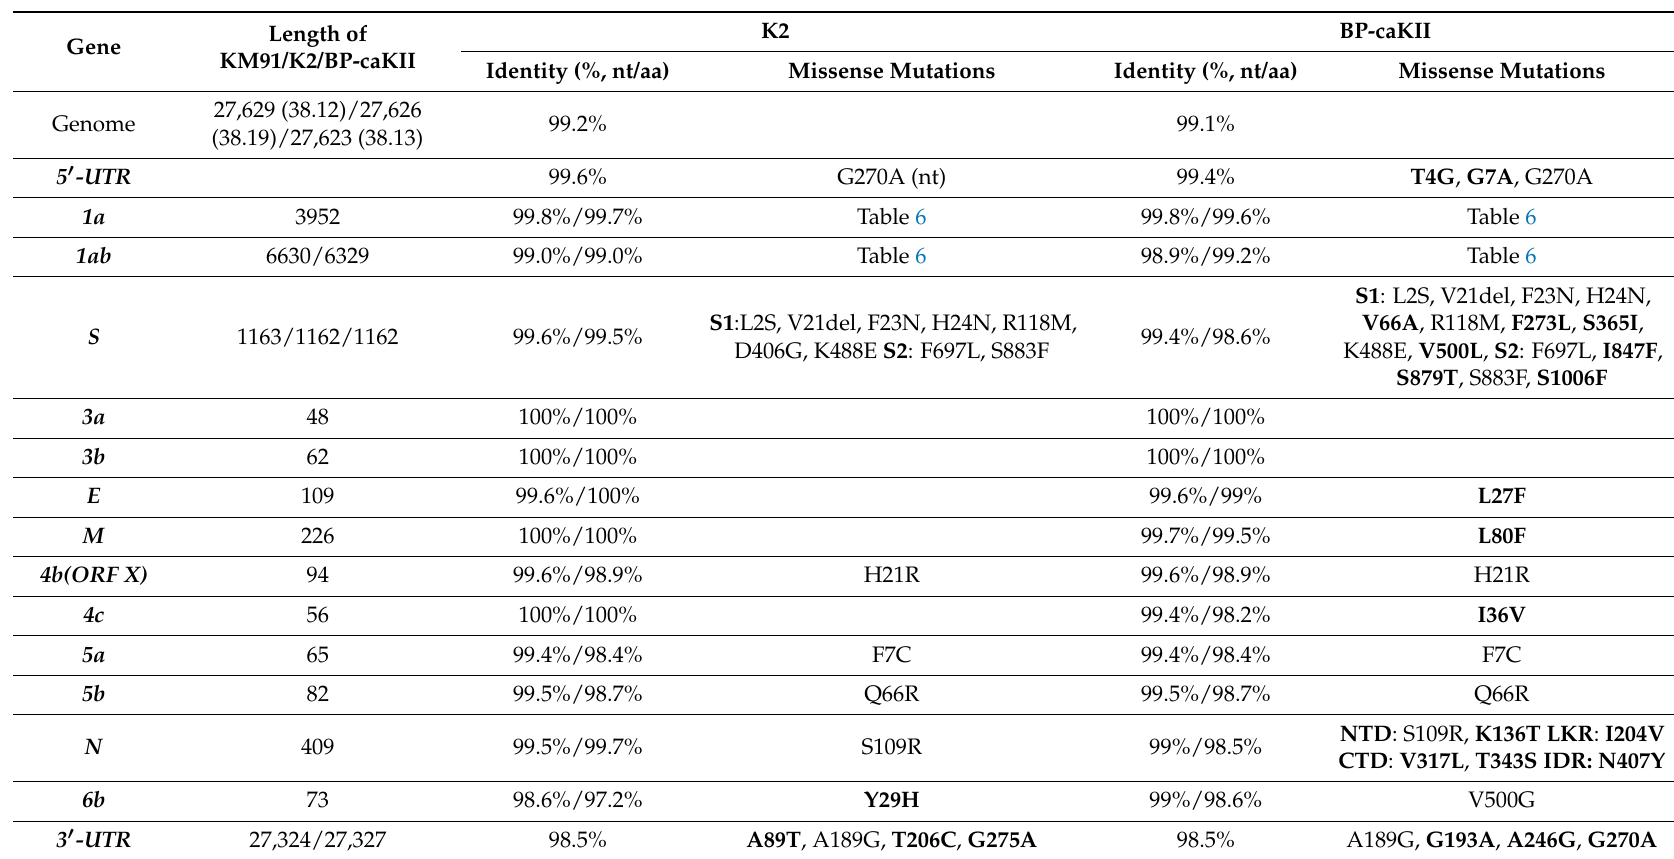
Table 5. Comparison of nucleotide and amino acid sequences of KM91 with K2 and